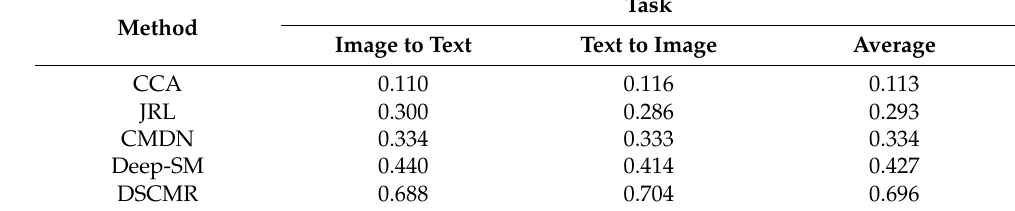
Table 2. The mAP values of the cross-modal retrieval performance on the Pascal Sentence dataset. Method